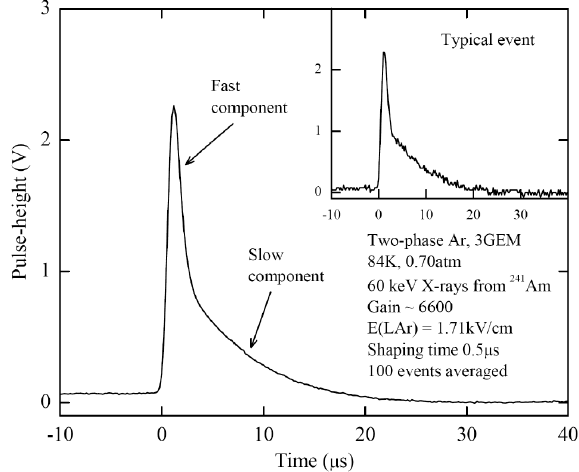
Figure 17. Typical anode signals in two-phase Ar detector with triple-GEM multiplier charge readout at emission electric field in the liquid of 1.7 kV / cm [4,69]. The fast and slow components of electron emission through liquid-gas interface are distinctly seen.